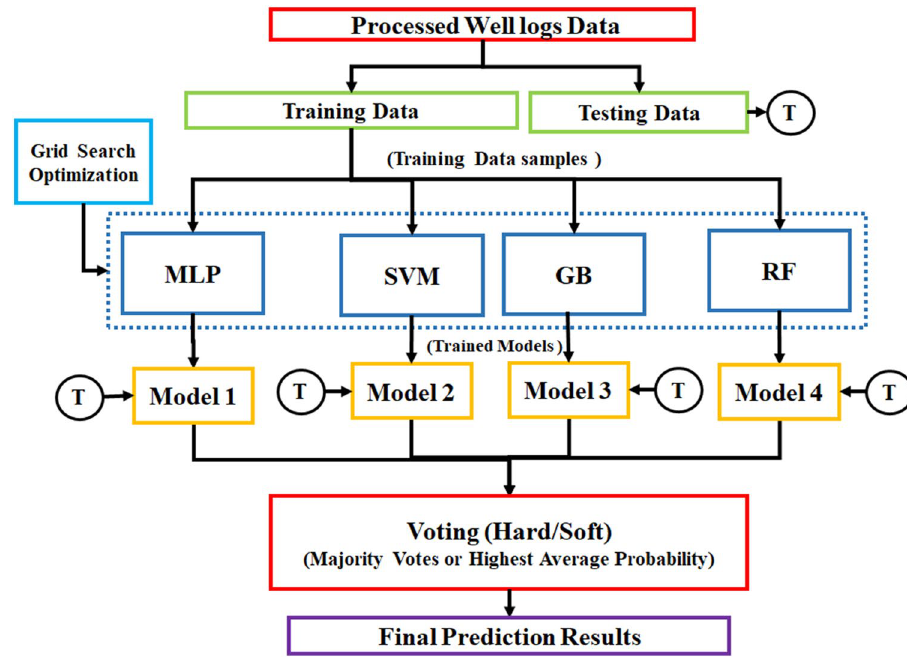
of voting ensemble utilized for quantitative lithofacies mod- eling in this